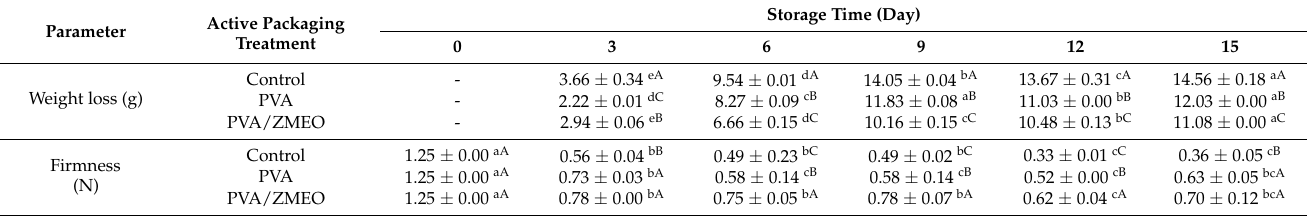
Table 3. Effect of active packaging using PVA fiber (PVA) and PVA fiber loaded with Zataria Multifora essential oil (PVA/ZMEO), and storage time on weight loss, firmness and color parameters of strawberry fruits stored at 4 °C for 15 days.